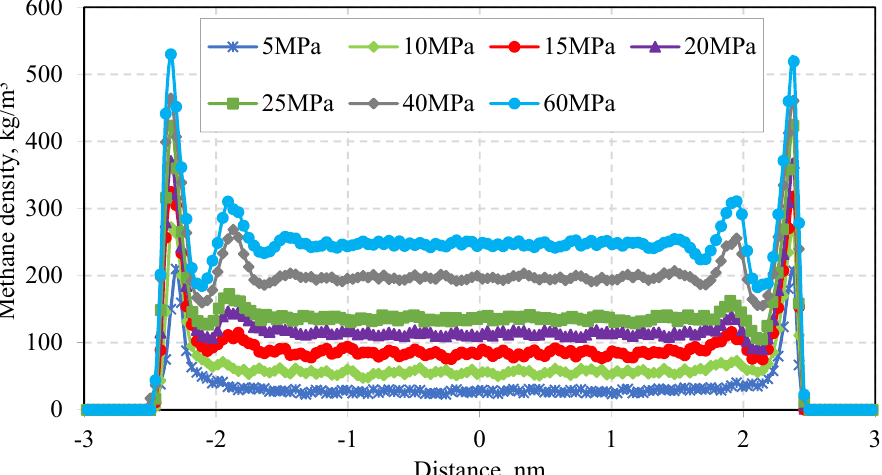
Figure 12. Methane density distribution curve in illite slit-shaped pore space (including pore walls).